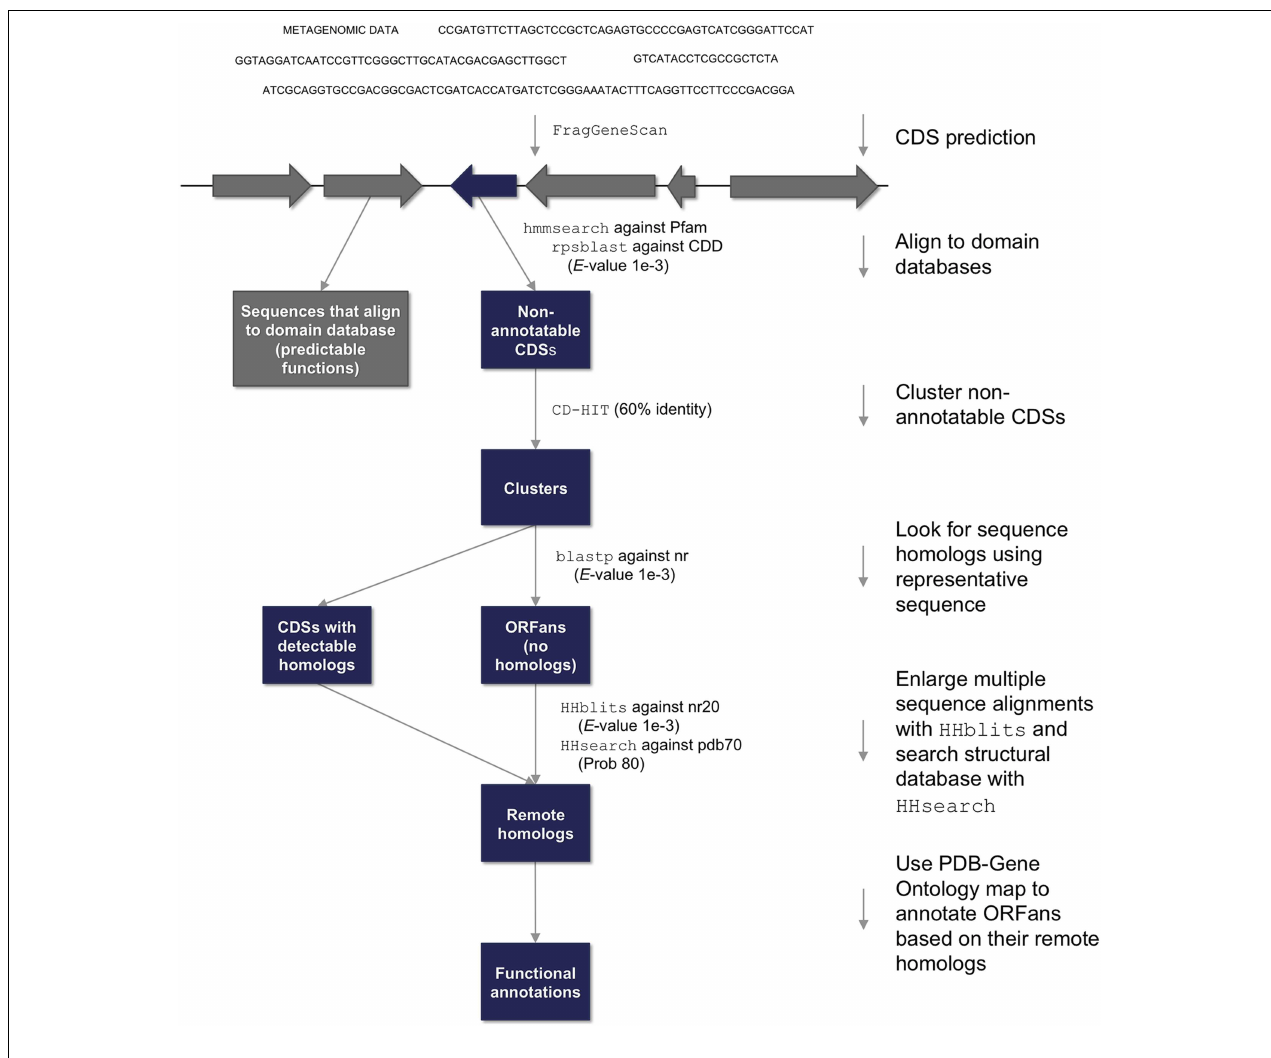
representatives were BLASTed against the NCBI nr database. Remaining CDS clusters lacking detected homologs were considered ORFans, and these were subjected to remote homology detection using HHblits and HHsearch, which were used to perform profile-profile searches against the Protein Data